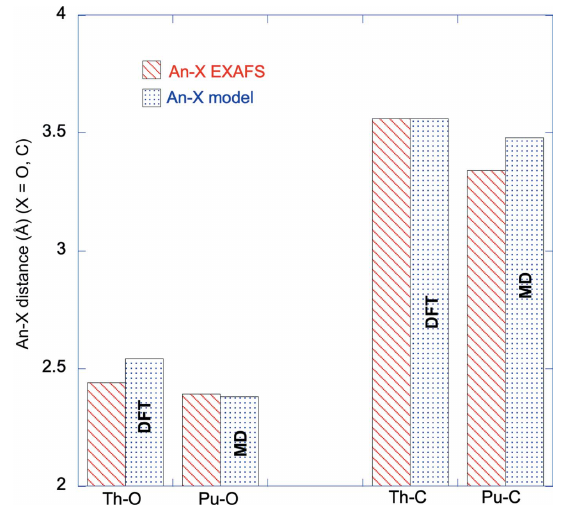
Figure 4 Comparison of the various distances obtained for the F-Th and F-Pu complexes. Data obtained with EXAFS data fitting (Zurita et al. , 2021) and data obtained from simulation (MD for Pu and DFT for